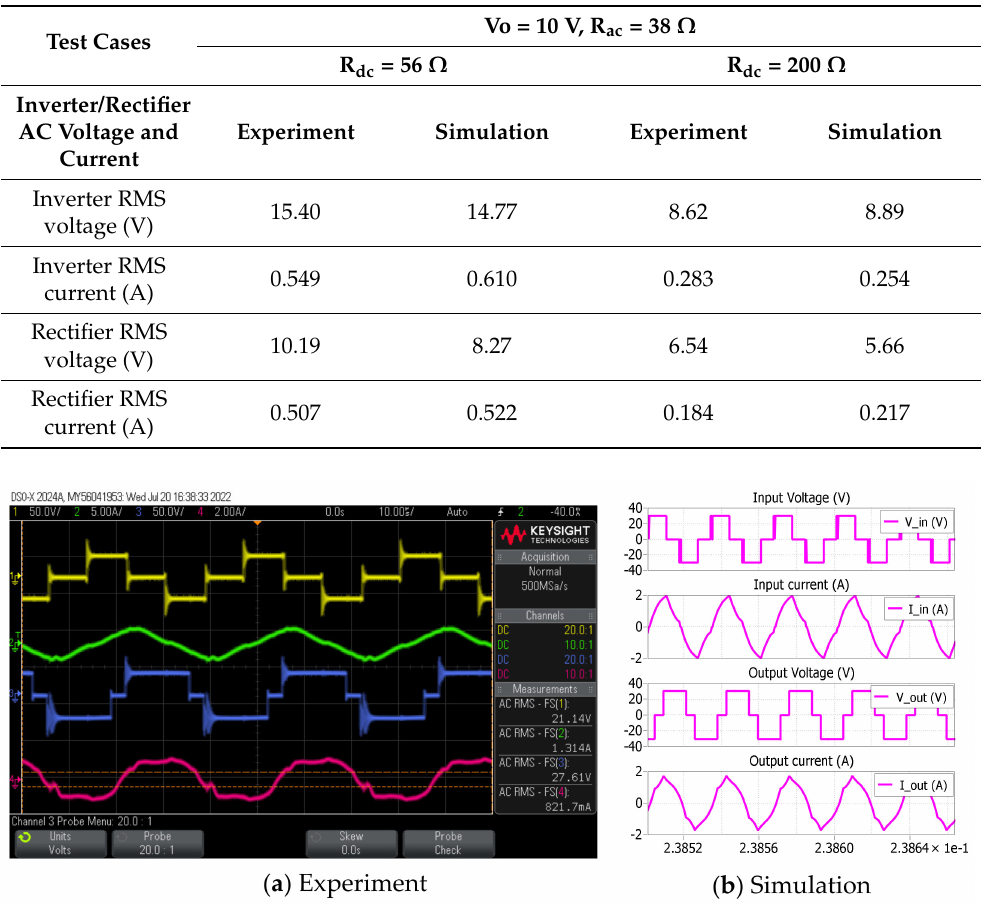
Table 6. DAB Inverter/rectifier voltage/current for R dc =56 Ω vs. R dc = 200 Ω .